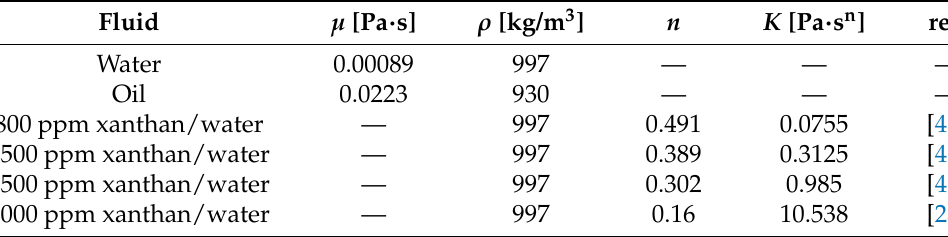
Table 1. Physicalpropertiesofthefluidsusedandpower-lawparametersofthexanthanaqueoussolutions.